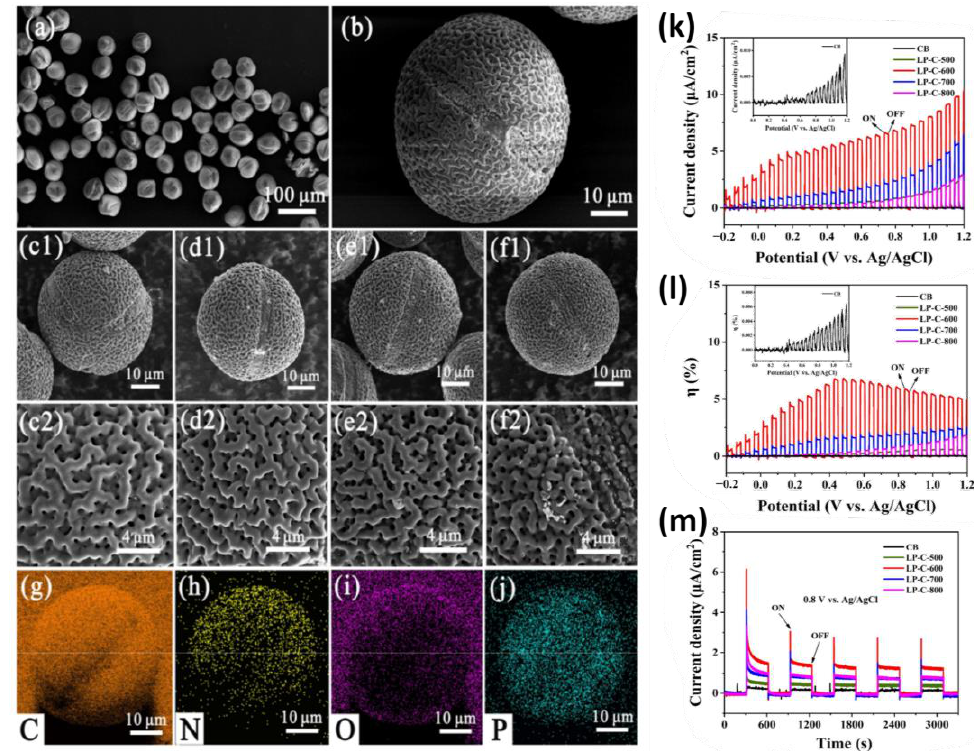
Figure 18. SEM images of ( a , b ) LP-Et, ( c1 , c2 ) LP-C-500, ( d1 , d2 ) LP-C-600, ( e1 , e2 ) LP-C-700, and ( f1 , f2 ) LP-C-800. ( g – j ) Element mapping images of C, N, O, and P in LP-C-600. ( k ) Linear sweep voltammogram (LSV) curves, ( l ) photoelectric conversion efficiency, and ( m ) photocurrent density time plot at applied voltage of 0.8 V of samples under test conditions with 0.1 M Na 2 SO 4 . Adapted with permission from ref. [110].